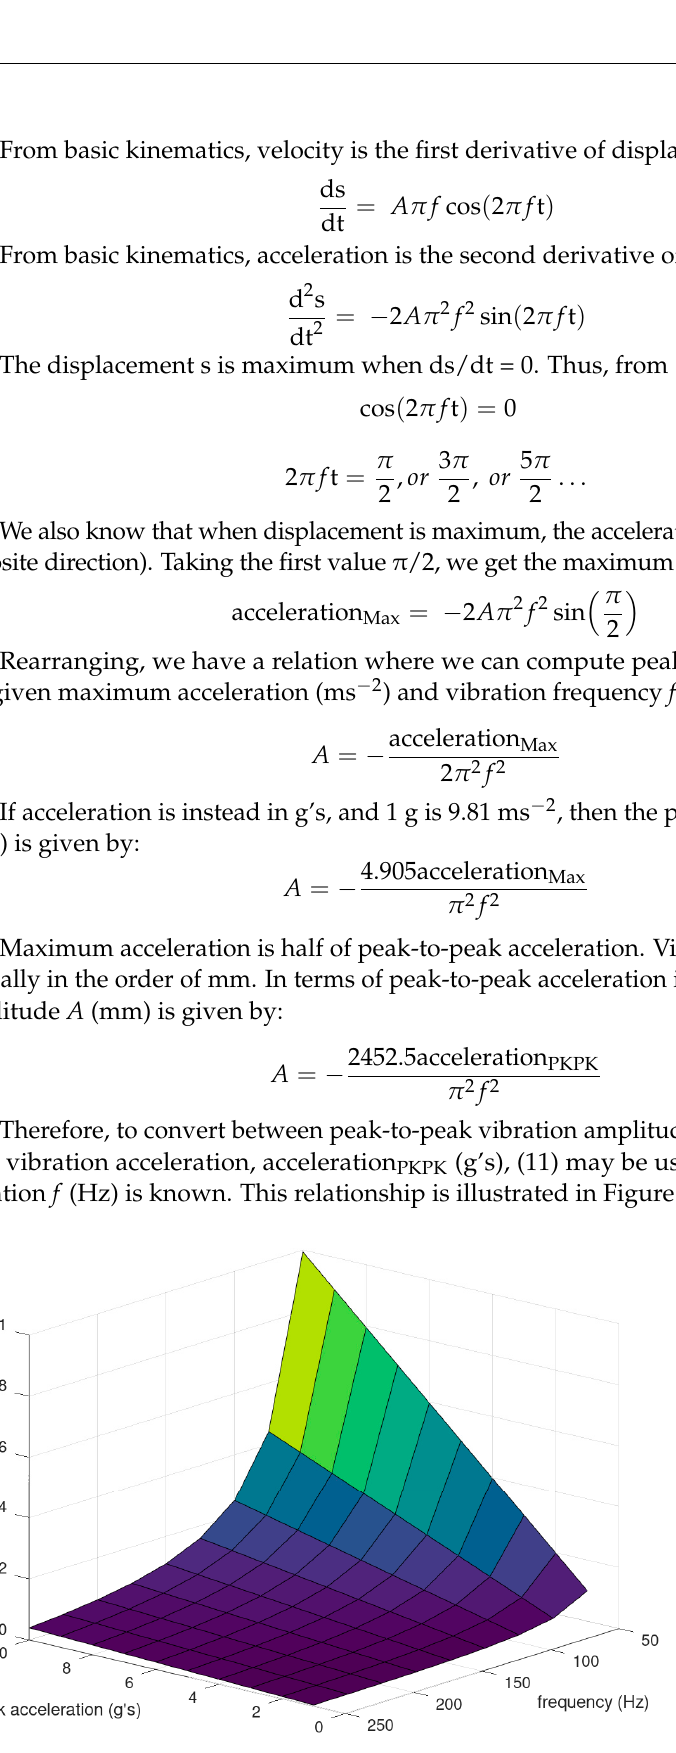
Figure 4. The relationship between peak-to-peak vibration amplitude (mm) and peak-to-peak vi- bration intensity (g’s) at frequencies of 50 to 250 Hz. The general relationship is summarized in Equation